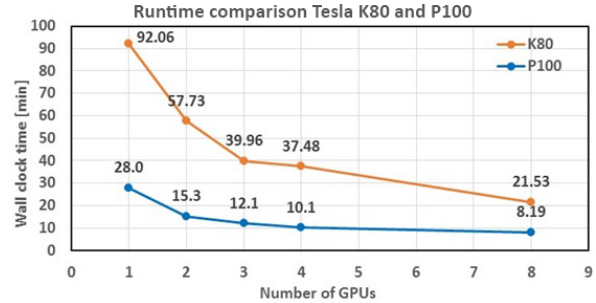
Figure 17. Wall-clock comparison of 10h simulation on Tesla K80 and Tesla